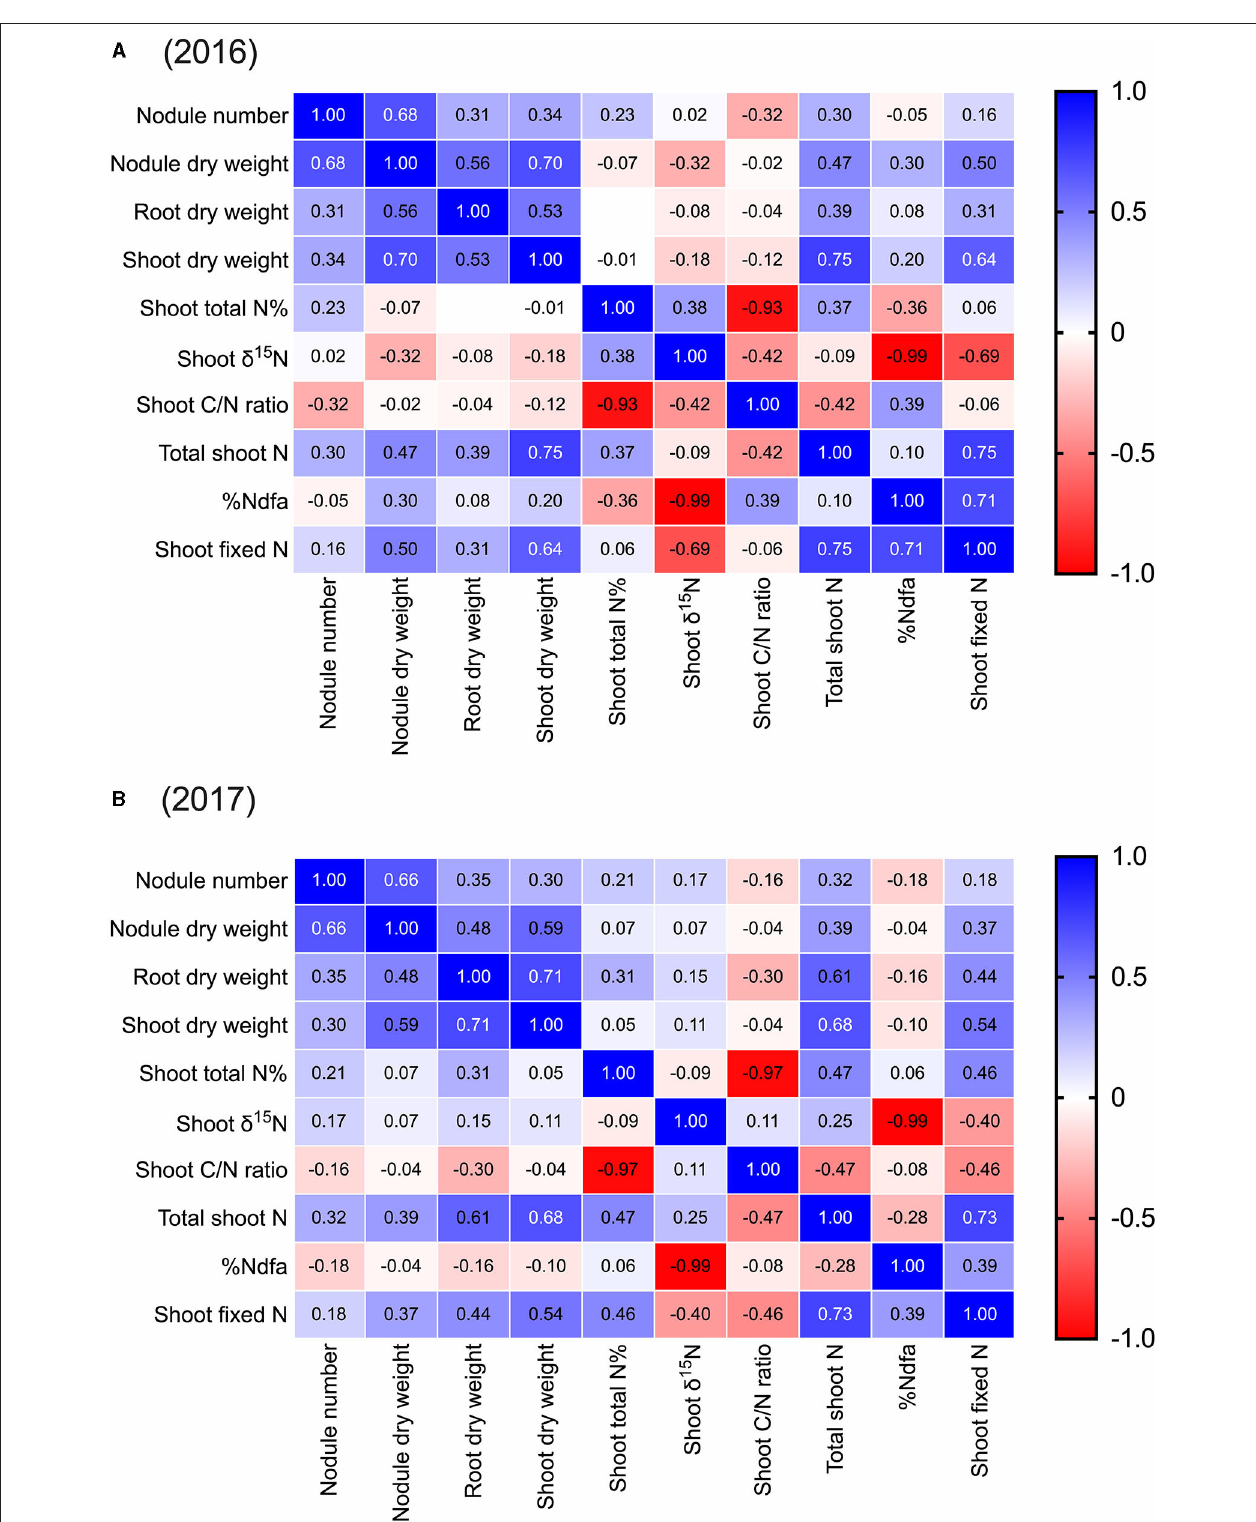
FIGURE 4 | Pearson correlation matrix for pre-pod-fill nodulation parameters (nodule number and dry weight), plant growth (root and shoot dry weight), shoot nitrogen (nitrogen concentration and total nitrogen), shoot δ 15 N, shoot C/N ratio, and shoot nitrogen fixation (%Ndfa and total nitrogen fixed) in soybean in 2016 and 2017 (using mean data). Correlation coefficients ( r ) in individual cells represent each correlation between variables. The boldness of the color represents the strength of the relationship between variables, with stronger correlations having bolder colors.